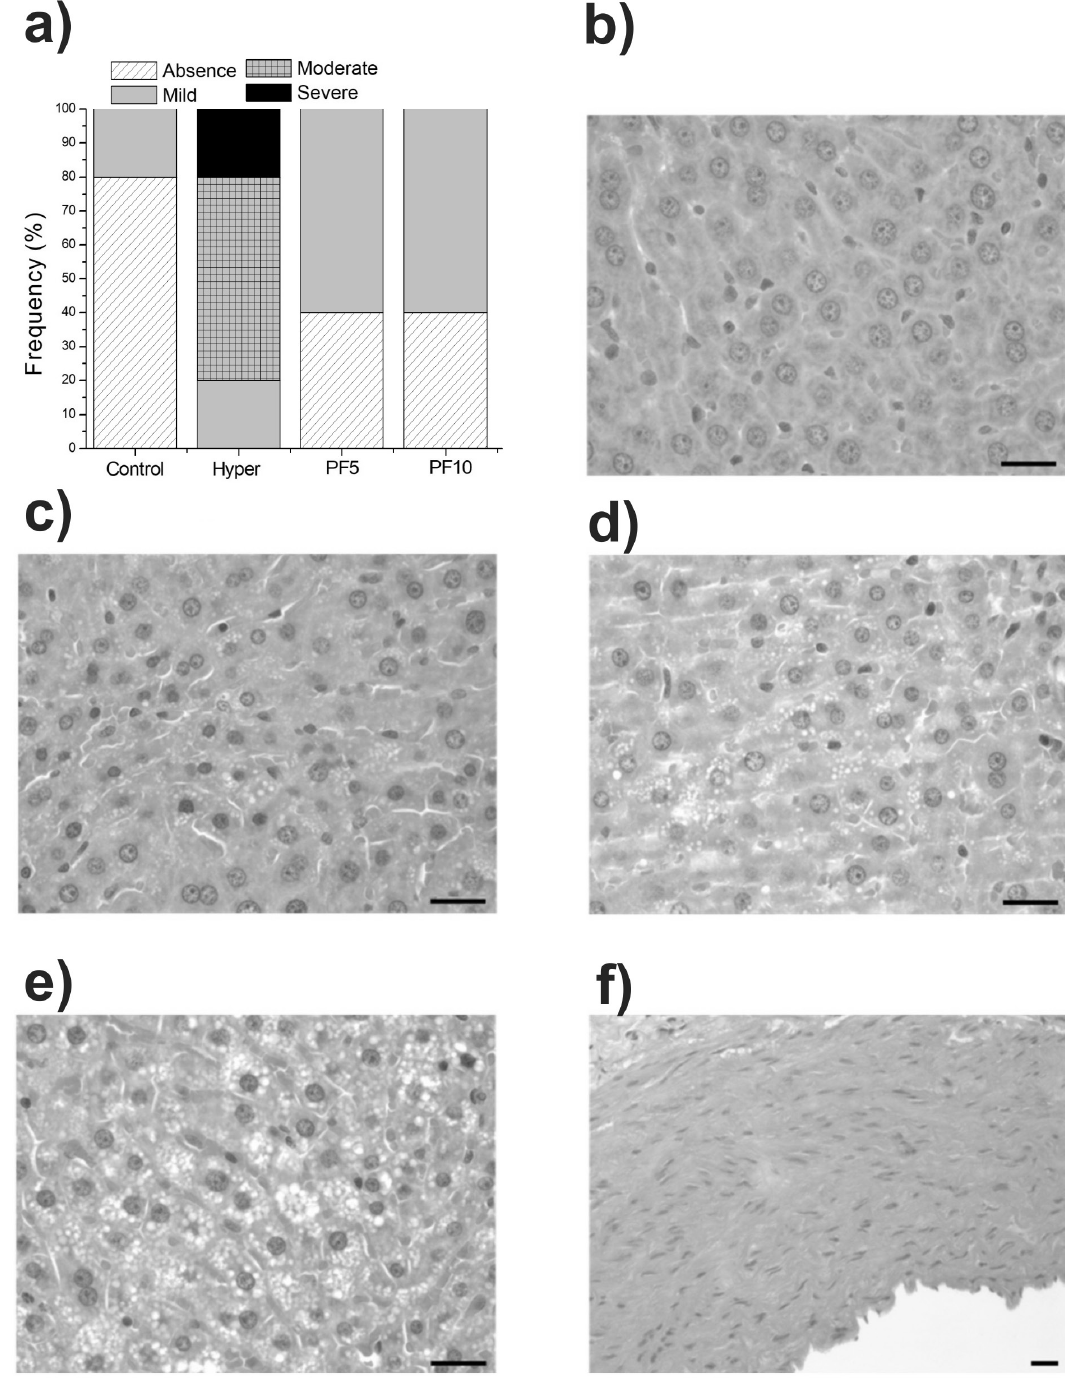
Figure 2 - Frequency of degrees of steatosis and histological analysis of liver and aorta of animals in the groups: Control (standard diet AIN-93G), Hyper (hypercholesterolemic diet), PF5 (hypercholesterolemic diet + 5% peel flour) and PF10 (hypercholesterolemic diet + 10% peel flour) at the end of 42 days of treatment. ( a ) frequency of degrees of steatosis, ( b ) absence of steatosis, ( c ) mild steatosis, ( d ) moderate steatosis, ( e ) severe steatosis, ( f ) aortic arch. Stained with hematoxylin-eosin. 40X magnification (from b to e ) and 20X in f